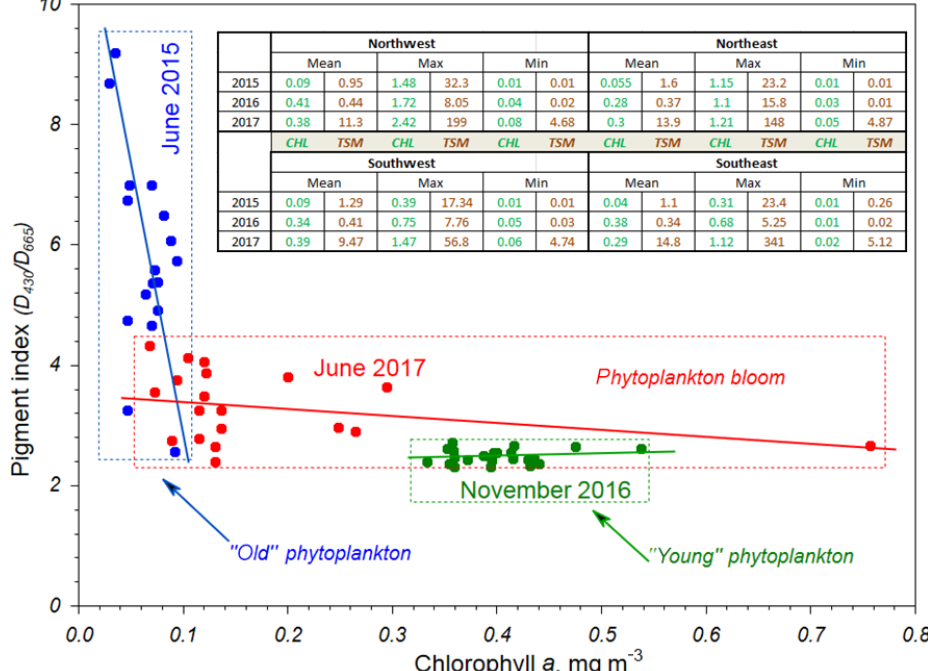
Figure 12. Chlorophyll- a concentration and CCI pigment index for June 2015 (blue bullets), November 2016 (green bullets), and June 2017 (red bullets). The straight lines represent linear regressions. The concentrations of chlorophyll (mgm − 3 , “CHL” columns) and total suspended matter (gm − 3 , “TSM” columns) are also exhibited in the inset table as the minimum and the maximum values and averages in four parts of the lake, delimited here by the 42.45 ◦ N parallel and the 77.4 ◦ E